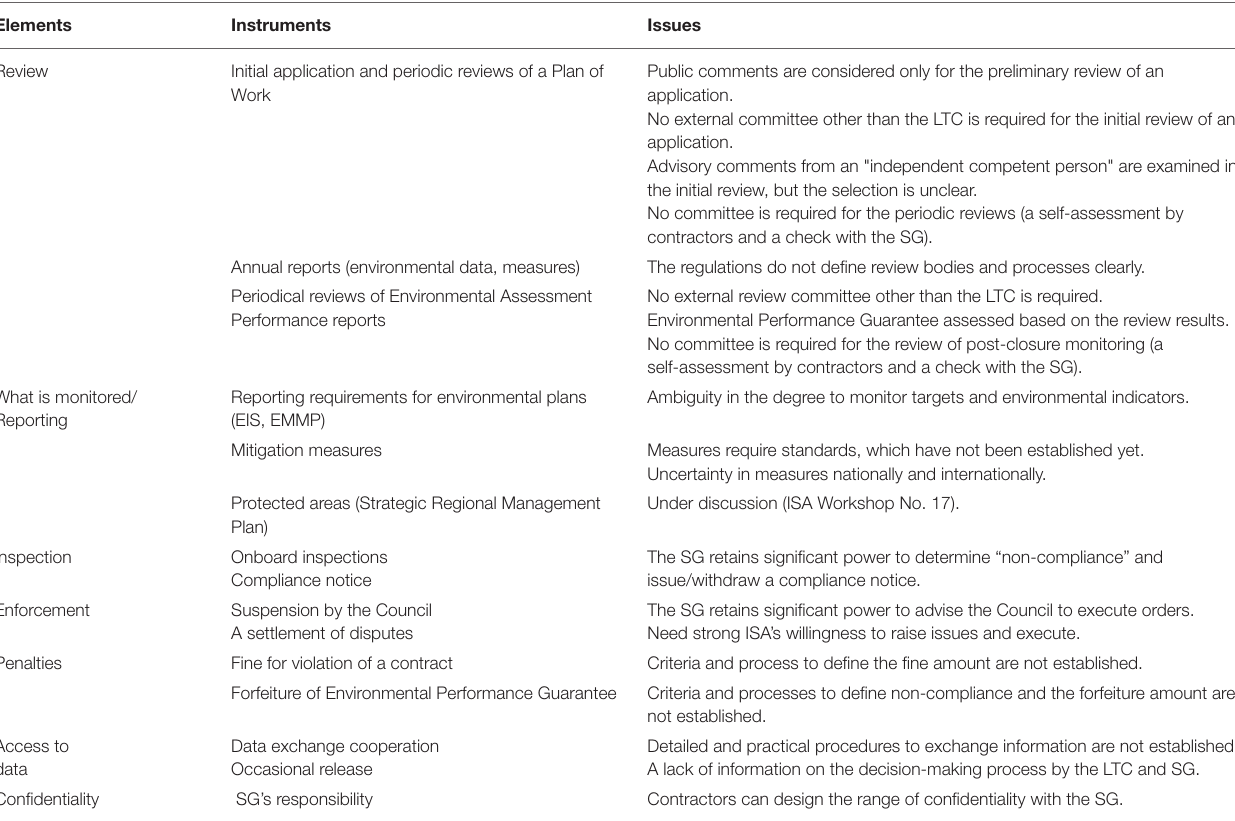
TABLE 3 | Potential issues of the ISA monitoring system for ISA